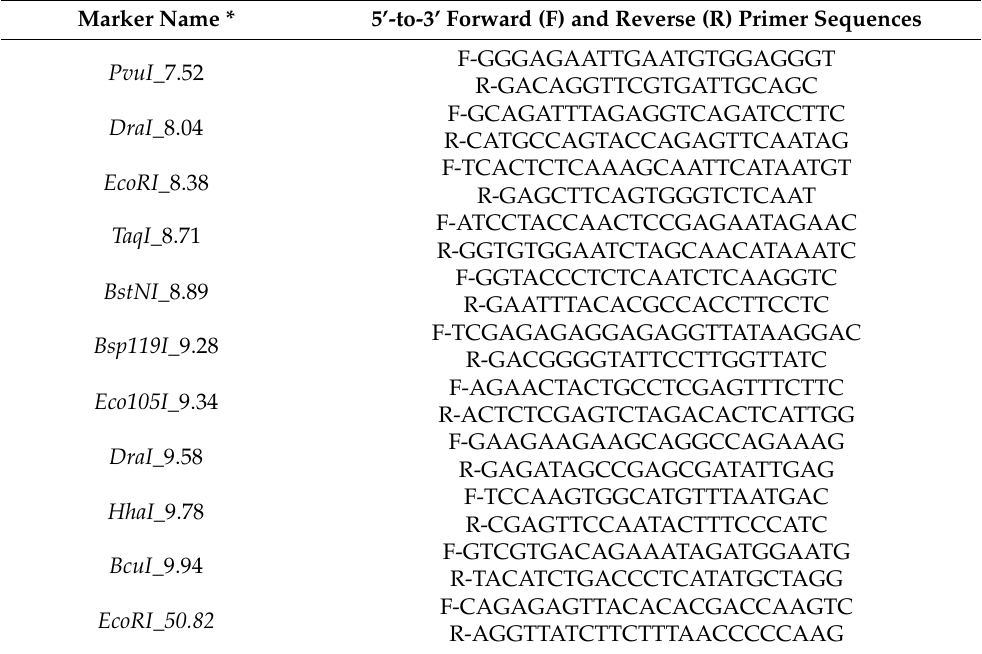
Table 5. Primers used to obtain sequence-characterized amplified region (SCAR) DNA markers for the association studies on chromosome 11.